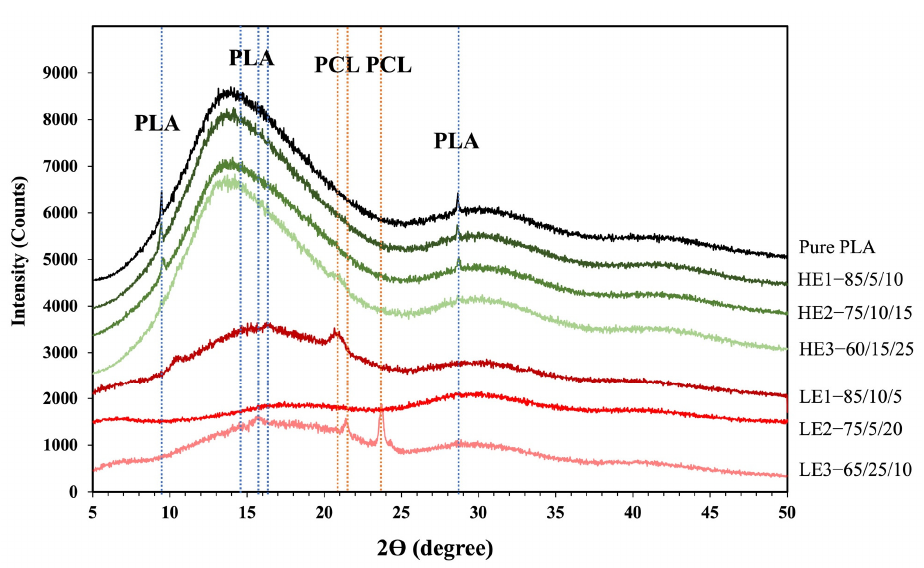
Figure 6. X-ray diffraction patterns of ternary-blended, melt-blown films of PLA/PCL/CAB at different compositions.